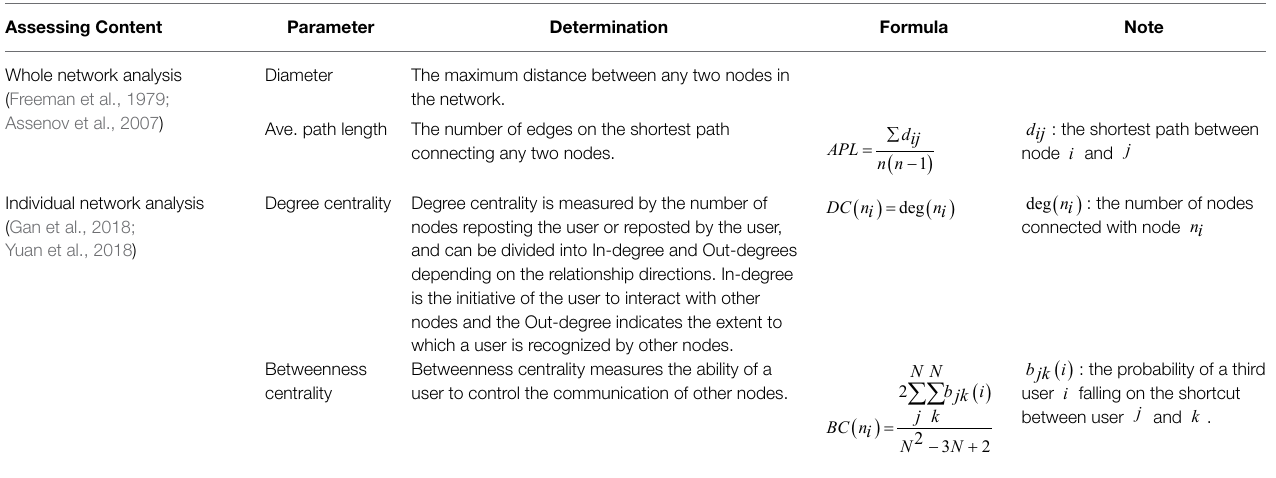
TABLE 1 | Specific SNA